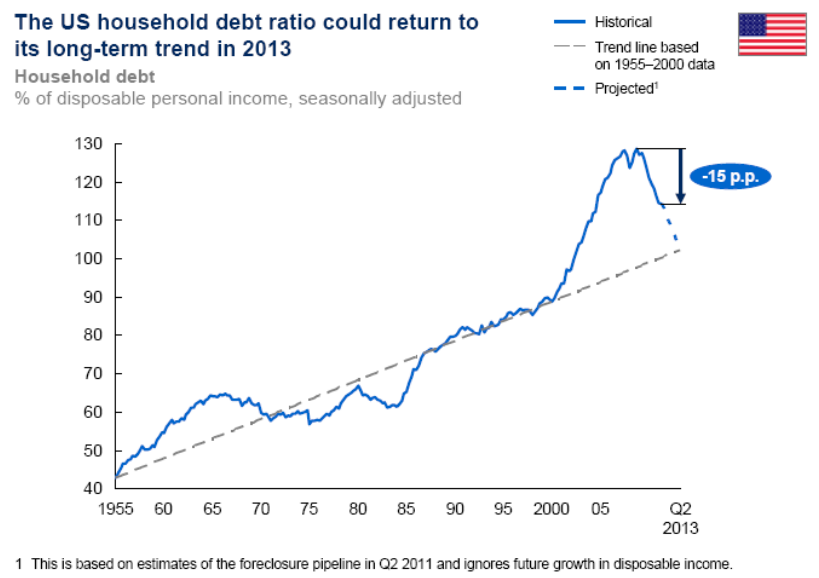
Figure 8. U.S. household debt as percentage of gross disposable income